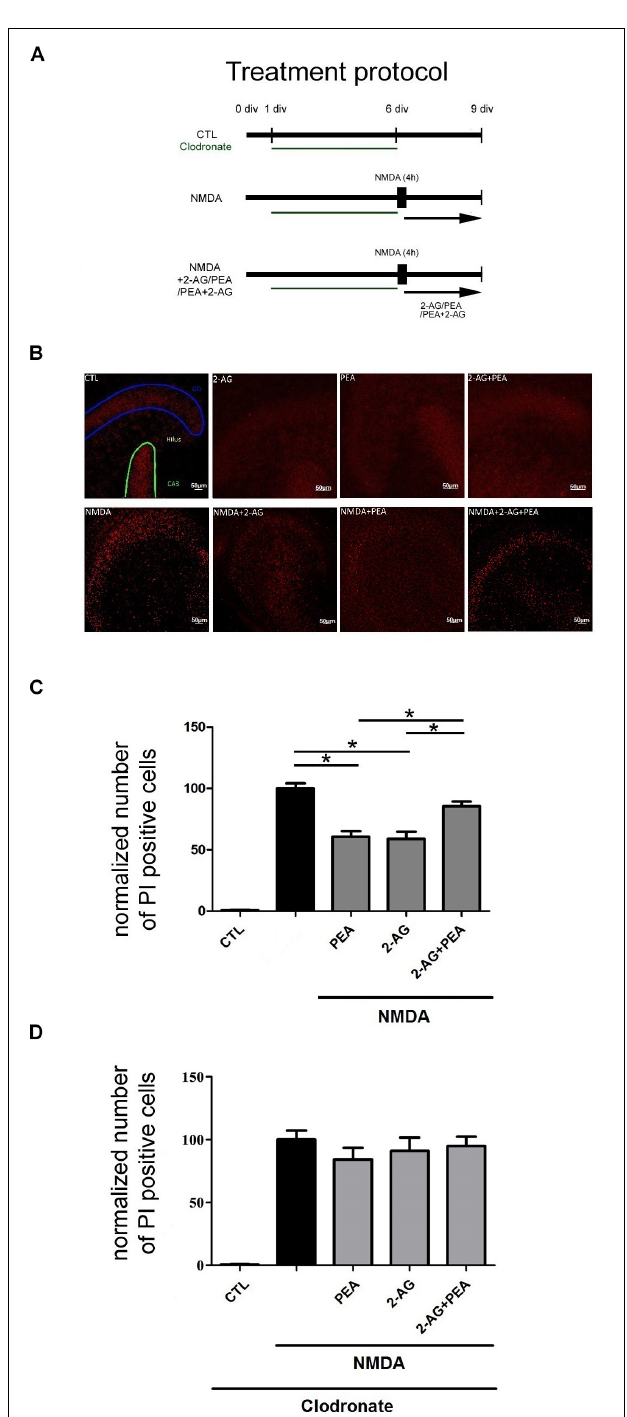
FIGURE 2 | Effects of 2-AG and PEA in excitotoxically damaged OHSC. 2-AG and PEA did not further decrease the number of PI positive degenerated neurons in comparison to OHSC treated with 2-AG or PEA alone. (A) Treatment protocol. Control OHSC (CTL), were kept in culture medium and served as negative controls. The NMDA treated group function as positive control (NMDA). For microglial cells depleted groups clodronate (green) was applied from 1 div until 6 div. Cannabinoids were added alone on day 6 in vitro